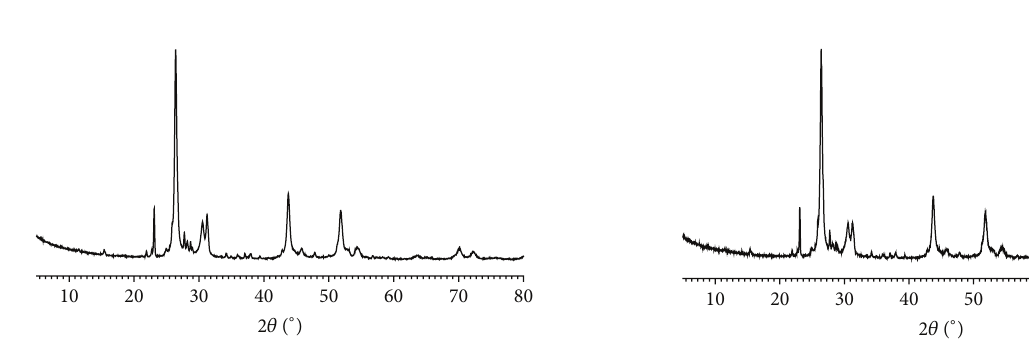
Figure 4: Structures of phase compositions in Zuotai samples. Note: (a), (b), and (c) are the crystal structures of 𝛽 -HgS, 𝛼 -HgS, and S 8 , respectively.